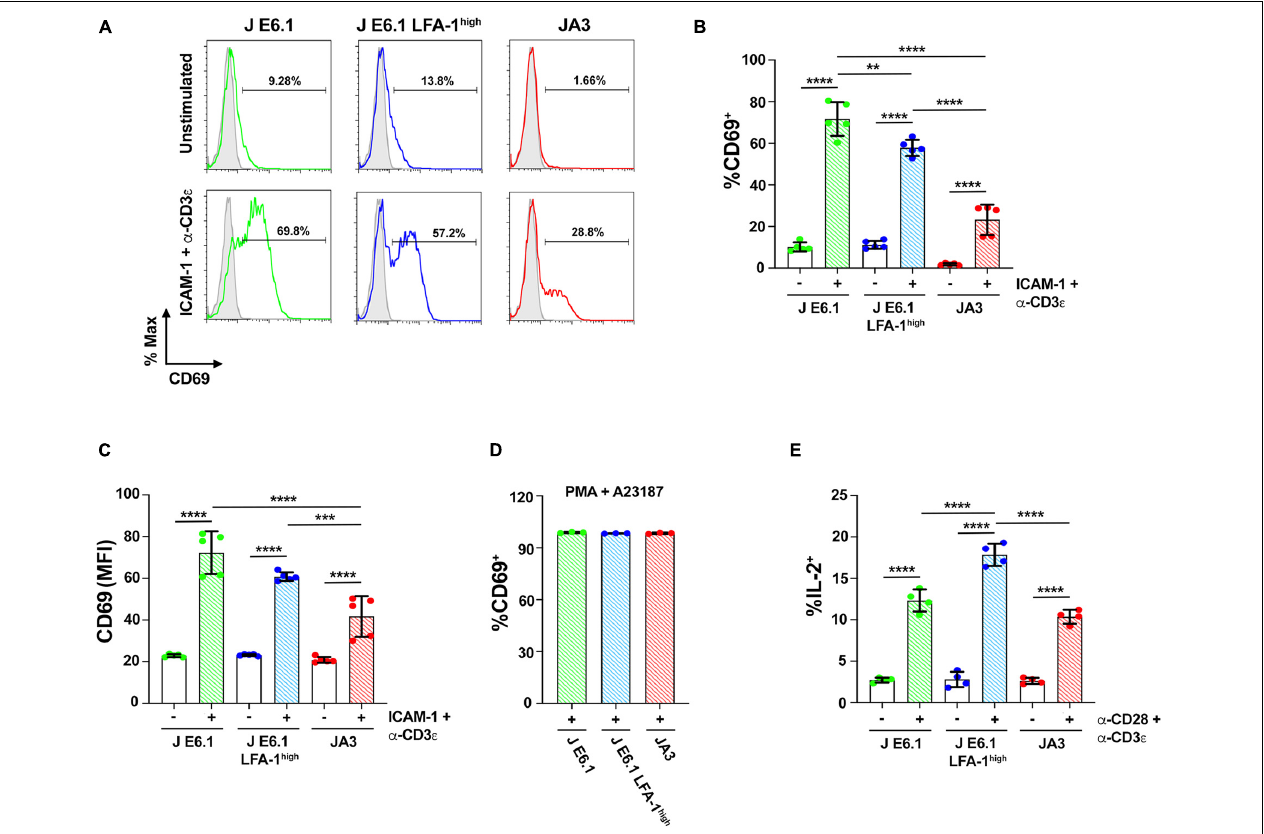
FIGURE 5 | Increasing LFA-1 expression in E6.1 cells improves IL-2 expression. (A) Representative FACS profiles of CD69 staining in E6.1, E6.1 LFA-1 high or JA3 Jurkat cells either unstimulated or plated on glass-immobilized ICAM-1 and anti-CD3 ε mAb, clone OKT3 for 16 h. (B,C) Histograms showing the percentage (%) of CD69 + cells (B) and CD69 MFI (C) among cells activated as in (A) (mean ± SD; One-Way ANOVA test; n ≥ 3). (D) Histogram showing the percentage (%) of CD69 + cells among JA3, E6.1 and E6.1 LFA-1 high Jurkat cells stimulated for 16 h with a combination of 100 ng/ml PMA and 500 ng/ml A23187 (mean ± SD; One-Way ANOVA test; n = 3). (E) Intracellular staining flow cytometry of E6.1, E6.1 LFA-1 high or JA3 Jurkat cells stimulated for 6 h on immobilized anti-CD3 ε , clone OKT3 and anti-CD28 mAb. A cocktail of brefeldin A and monensin was added in the last 1 h of culture. Cells were permeabilized and stained with anti-IL-2 mAb and the percentage (%) of IL-2 + cells was quantified by flow cytometry. Only significant differences are shown. ** p < 0.01; *** p < 0.001; **** p <